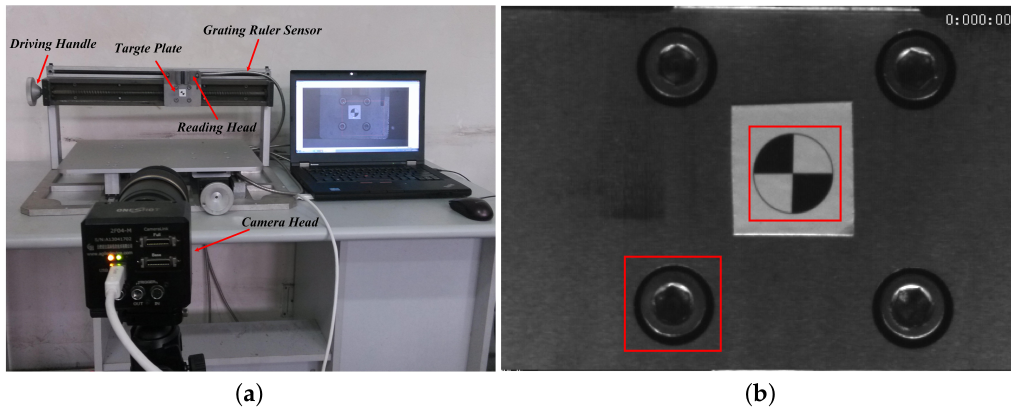
Figure 9. Experiment setup in moving platform experiment: ( a ) experimental device; ( b ) the selected artificial target and natural structure